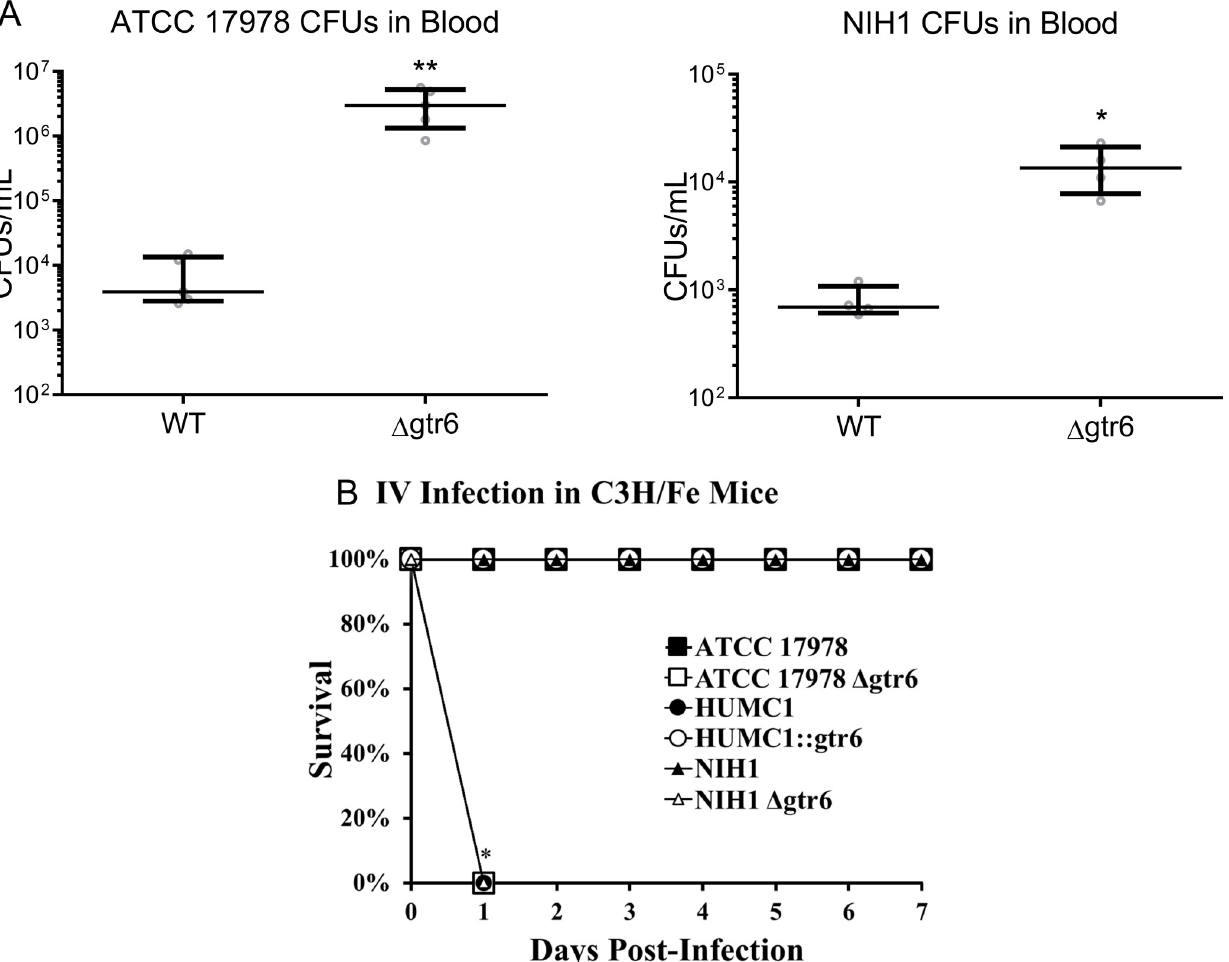
Fig 3. Bacterial blood burden and in vivo lethality by gtr6 genotype. (3A) Bacterial burden in the blood at 1-hour post-infection with 1.0 × 10 8 CFUs of ATCC 17978 WT and Δ gtr6 (left) and NIH1 WT and Δ gtr6 (right). � p < 0.001 (3B) C3HeB/Fe mice were infected intravenously with 2.4 × 10 8 CFUs of ATCC 17978 (black squares), 8.3 × 10 7 CFUs of ATCC 17978 Δ gtr6 (white squares), 1.0 × 10 8 CFUs of NIH1 (black circles) and NIH1 Δ gtr6 (white circles), 2.9 × 10 7 CFU of HUMC1 (black triangles), and 2.0 × 10 8 CFUs of HUMC1:: gtr6 (white triangles). � p < 0.05, �� p < 0.01. Wide bars denote median, error bars denote IQR. Experiments repeated once, n = 5 per group for in vivo .